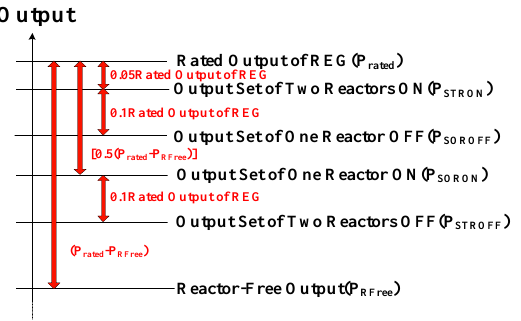
Figure 7. Output set of REG for ON and OFF of reactors.